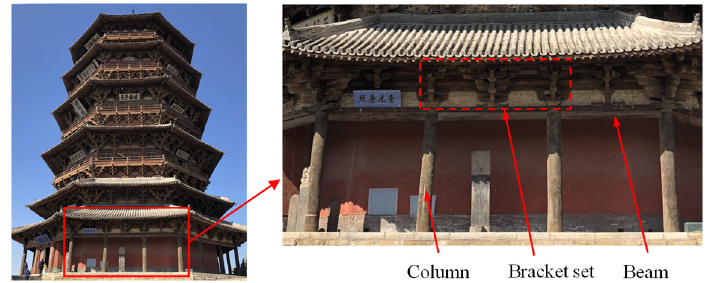
Figure 1. The Buddha Tower.